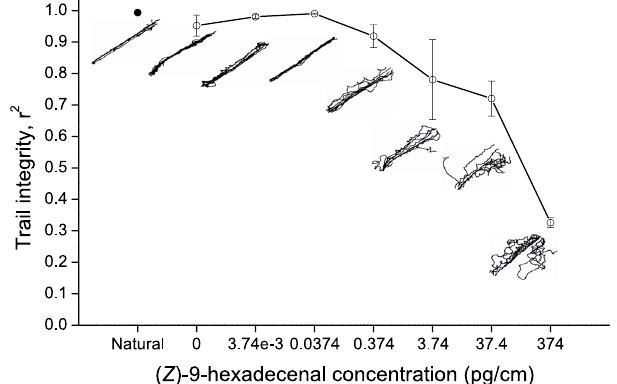
Figure 3. Trail integrity (r 2 ) for the Argentine ant Linepithema humile when trailing on a 20 cm length of thread either containing naturally laid trail pheromone (natural control [ ● ]), untreated or dipped in increasing trail pheromone ( Z )-9-hexadecenal concentrations ( ○ ). Typical tracks are displayed for one replicate from each treatment. Error bars show one standard error.